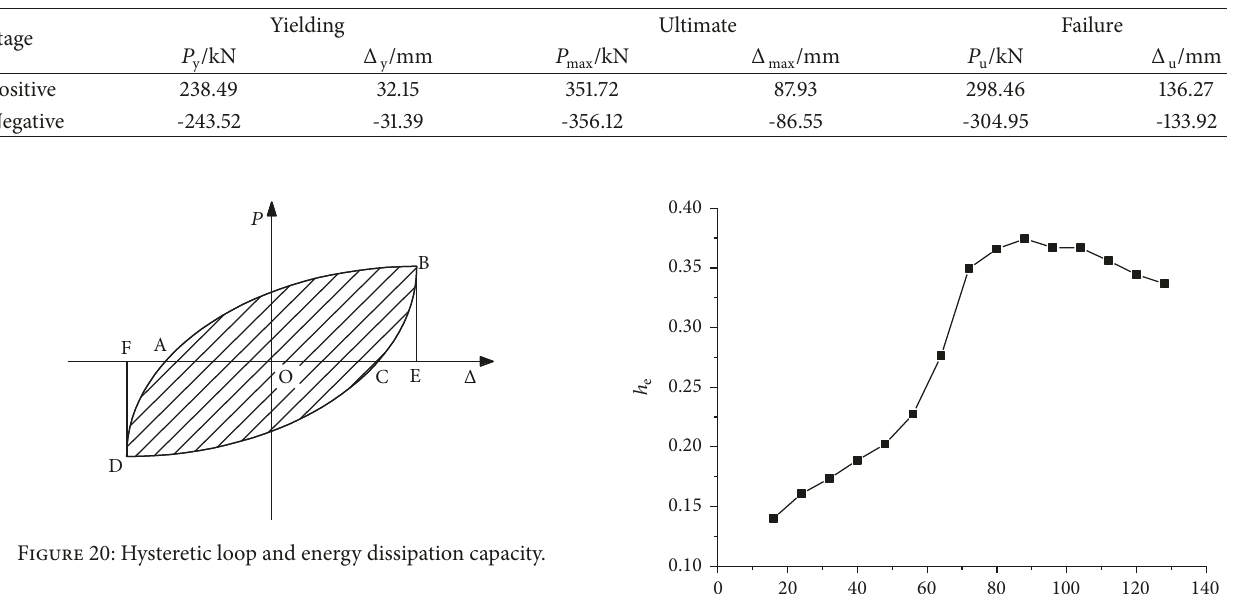
Table 5: Yielding, ultimate and failure point of specimen.